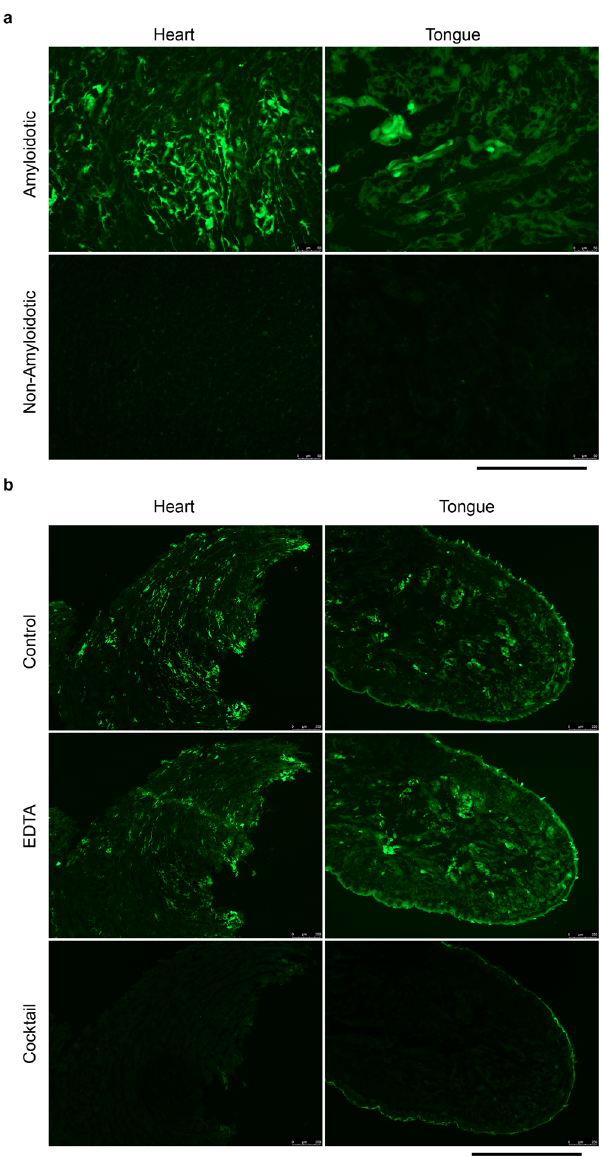
Fig. 5 Amyloid-associated protease activity. Protease activity in heart and tongue was visualised by in situ zymography using DQ-gelatin substrate overlaid on un fi xed cryosections. a protease activity was readily detected in hearts and tongues of amyloidotic mice, but not of control mice. b the amyloid-associated protease activity was insensitive to inhibition by EDTA, but was completely inhibited by a cocktail of serine protease inhibitors (aprotinin, PMSF and Pefabloc SC). The protease activity was associated with amyloid deposits, but the activity was not as extensively distributed as the amyloid (Fig. 2c). Scale bars: 250 µ m ( a ); 1 mm ( b ). Data are representative of a minimum of two technical replicates of two biological